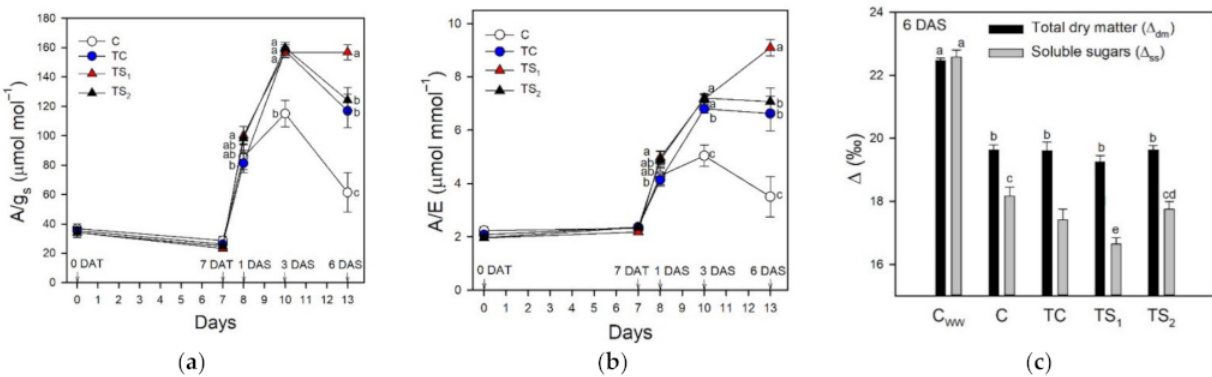
Figure 7. Water-use efficiency (WUE) and carbon isotope discrimination in leaves of purple basil cv. Red Rubin: ( a ) intrinsic WUE (A/g s ); ( b ) instantaneous WUE (A/E); ( c ) carbon isotope discrimination ( ∆ ) of leaf dry matter ( ∆ dm ) and leaf soluble sugars ( ∆ ss ). A/g s and A/E were determined at 0 and 7 days after bacterial treatment (0 DAT and 7 DAT, respectively) and at 1, 3, and 6 days after water stress (1 DAS, 3 DAS, and 6 DAS, respectively); ∆ dm and ∆ ss were determined at 6 DAS and compared to well-watered plants (C ww ). Values are means ± SE ( n = 10 for A/g s and A/E; n = 6 for ∆ dm and ∆ ss ). Different letters indicate significant differences among bacterial treatments and control (one-way ANOVA with Fisher’s LSD test, p ≤